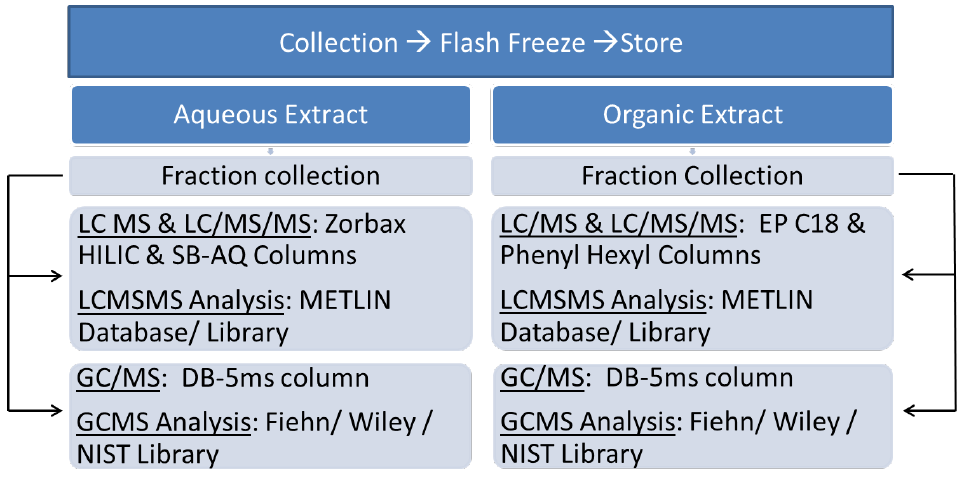
Figure 1. Summary of the workflow for biphasic solvent extraction followed by analysis using LC/MS and GC/MS platforms.